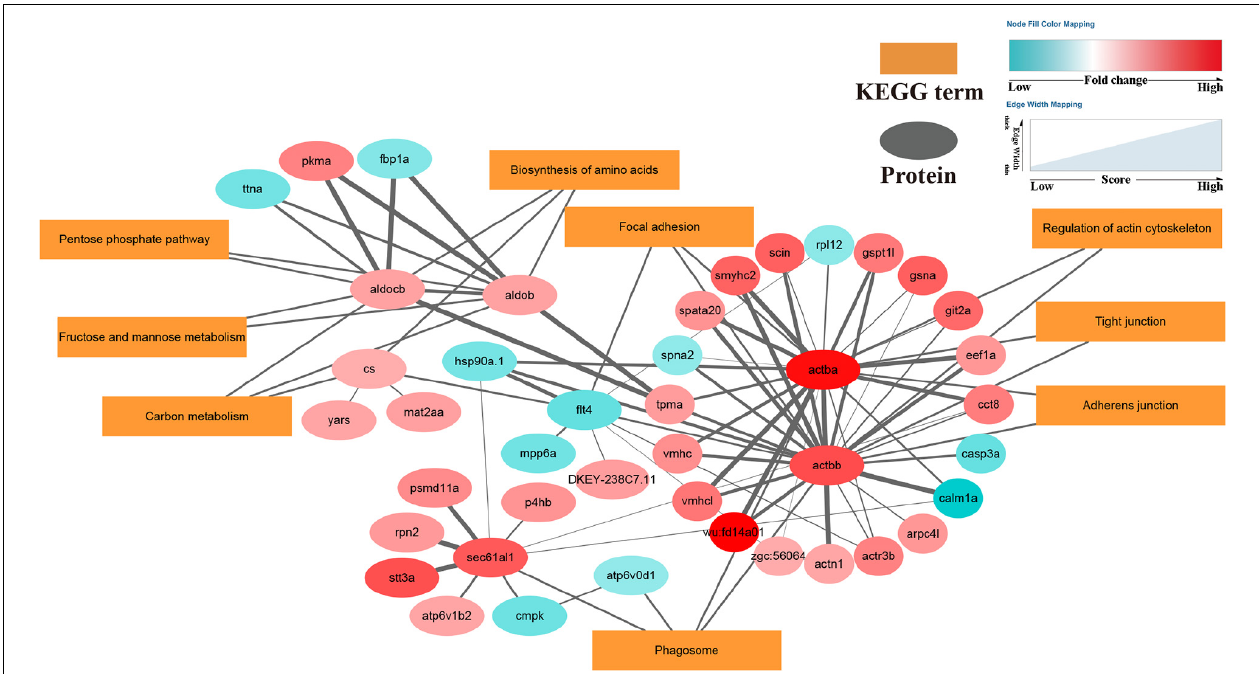
FIGURE 6 | DEPs enriched in the protein-protein interaction network in OA-exposed scallops. Proteins are shown as small elliptical nodes (blue nodes represent down-regulated proteins and red nodes represent up-regulated proteins) and are connected with associated KEGG pathways (rectangular Nodes). The size of the line between nodes represents the scoring value of the interaction between the two nodes, and the greater the score, the more